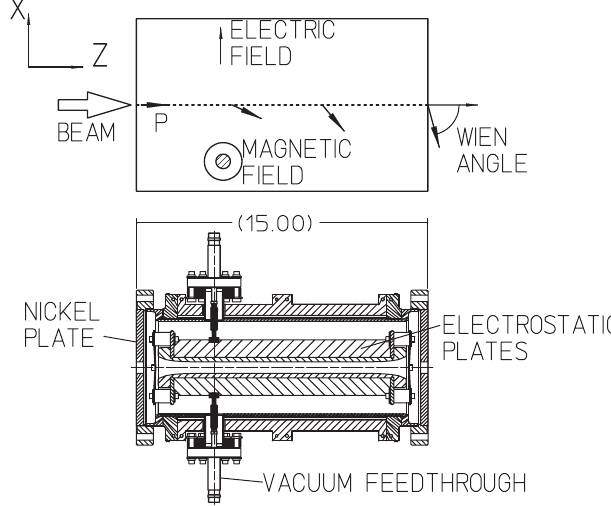
FIG. 4. The Wien filter spin manipulator used with CEBAF’s second and third polarized electron sources. The magnet is not shown in the cutaway view.